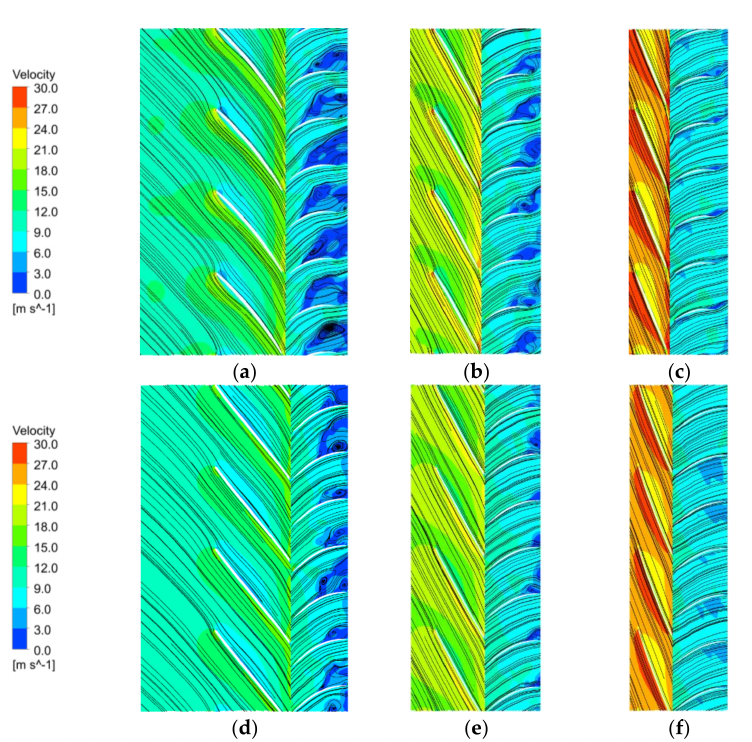
Figure 12. Velocity and streamline distribution in different spanwise. ( a ) Initial scheme at span = 20%. ( b ) Initial scheme at span = 50%. ( c ) Initial scheme at span = 80%. ( d ) Optimized scheme at span = 20%. ( e ) Optimized scheme at span = 50%. ( f ) Optimized scheme at span = 80%.